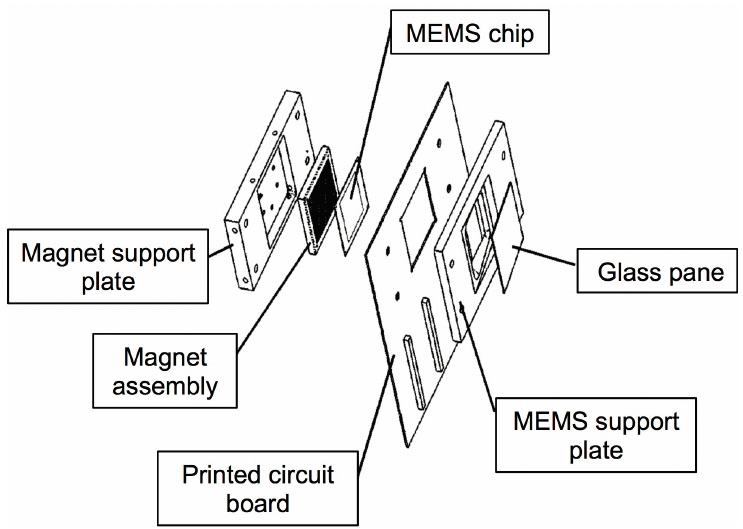
Figure 5. Example of MEMS mounted on permanent magnet assembly, exploded view [100]. Reprinted with permission from [100]. Copyright 2004